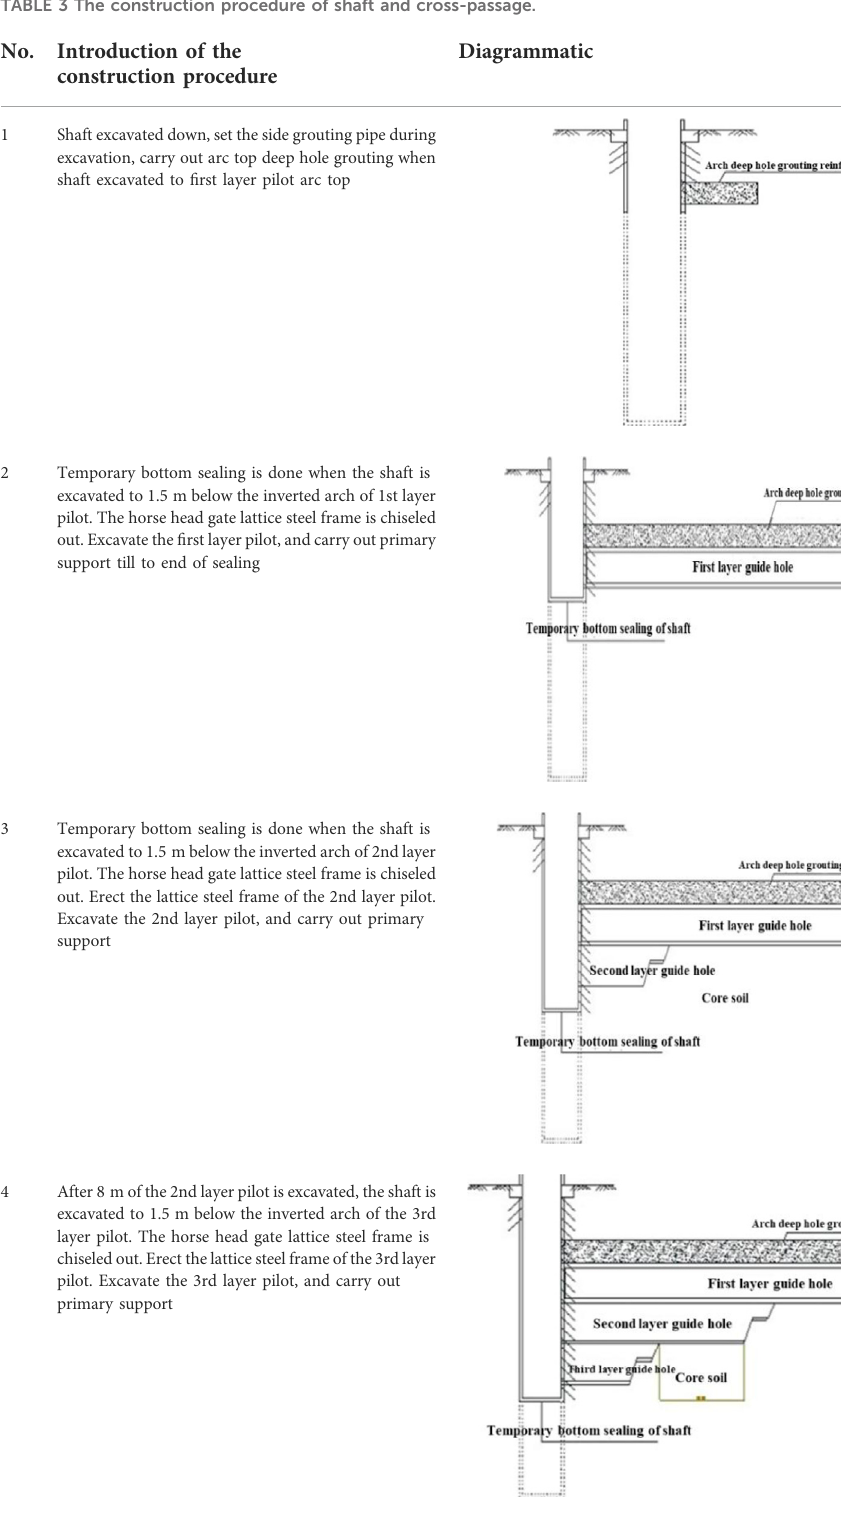
TABLE 3 The construction procedure of shaft and